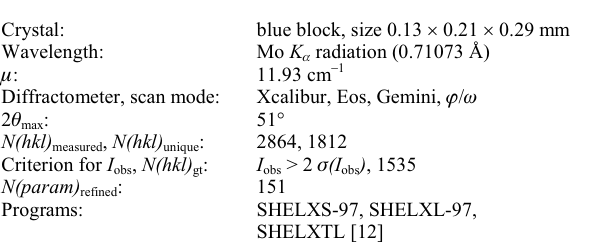
Table 1. Data collection and handling.